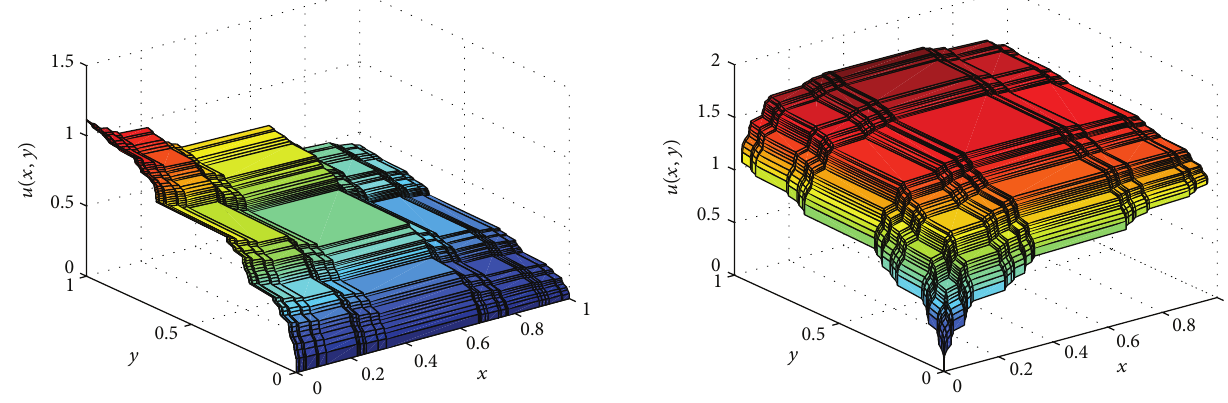
Figure 2: The plot of the solution of (9) with the local fractional derivative boundary value conditions (31) when 𝛼 = ln 2/ ln 3